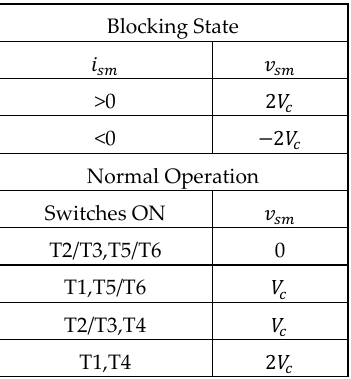
Figure 18. SCSM 430 431 Figure 19. The reverse blocking IGBT (RB-IGBT) unit consists of two antiparallel RB- IGBTs. Symmetrical fault blocking is provided with only two switches in on-state for any of the voltage states. This is an improvement over other SM configurations since conduc- tion losses are comparable to HBSMs. However, the lack of overmodulation capability is considered a drawback.